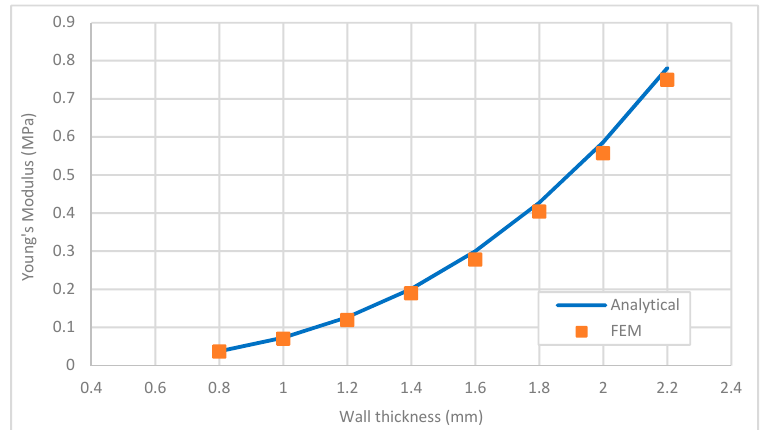
Figure 9. FEM (Finite Element Model) computational verification with analytical in-plane stiffness for a zero Poisson’s ratio skin.